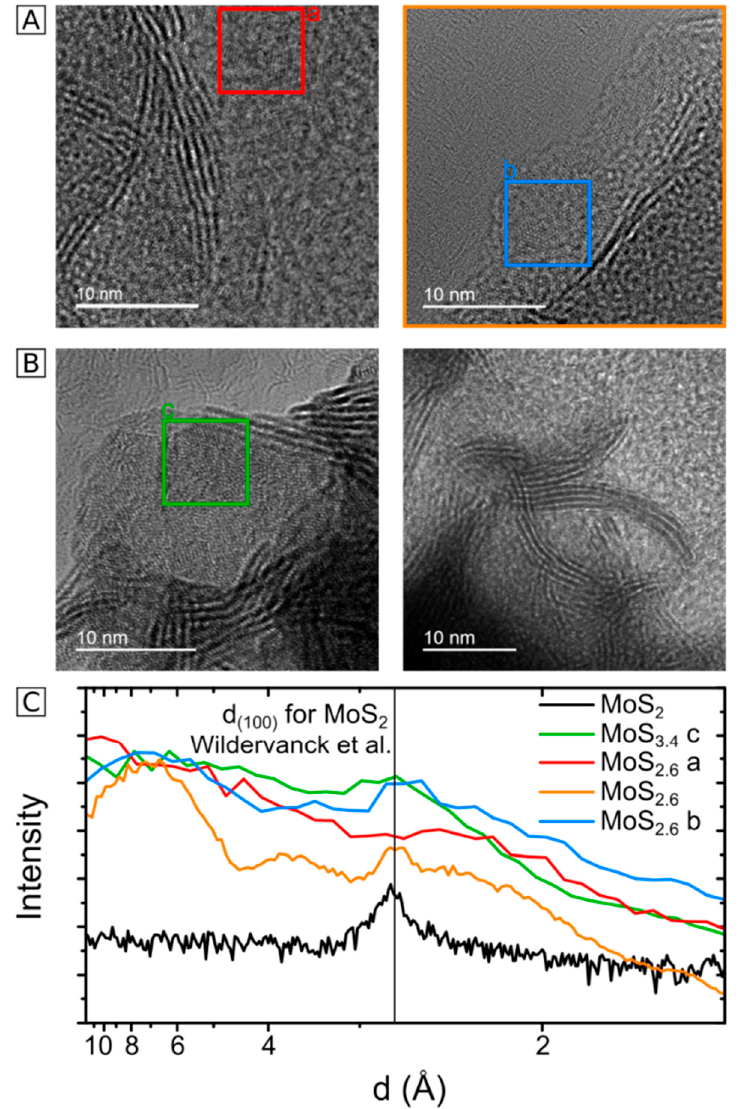
Figure 5. HRTEM analysis of nanocrystalline MoS 2 + δ . ( A ): HRTEM images of MoS 2.6 ; ( B ): HRTEM images of MoS 3.4 ; ( C ): representative FFT intensity profiles. The FFT of MoS 2 is taken from Figure S4A, and the other underlying FFTs can be found in Figure S5; The in-plane lattice spacing of MoS 2 d 100 = 2.737 Å (Wildervanck et al. [30]) is indicated. The region of interest of the FFT plots is marked with a rectangular in subfigure A and B with the corresponding color.